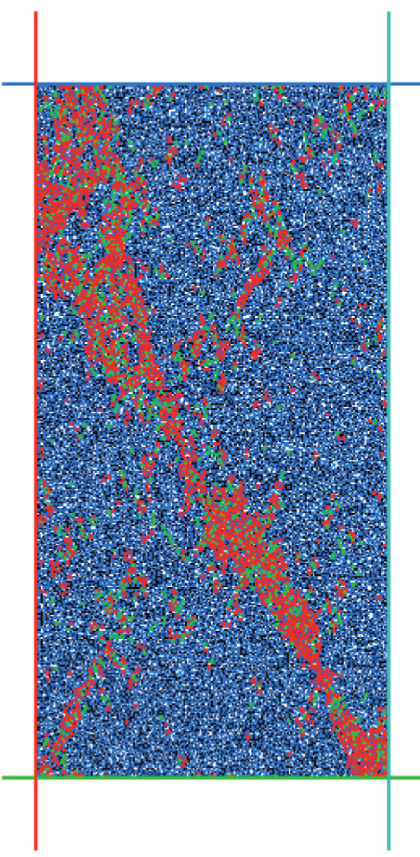
Figure 1: Numerical model for